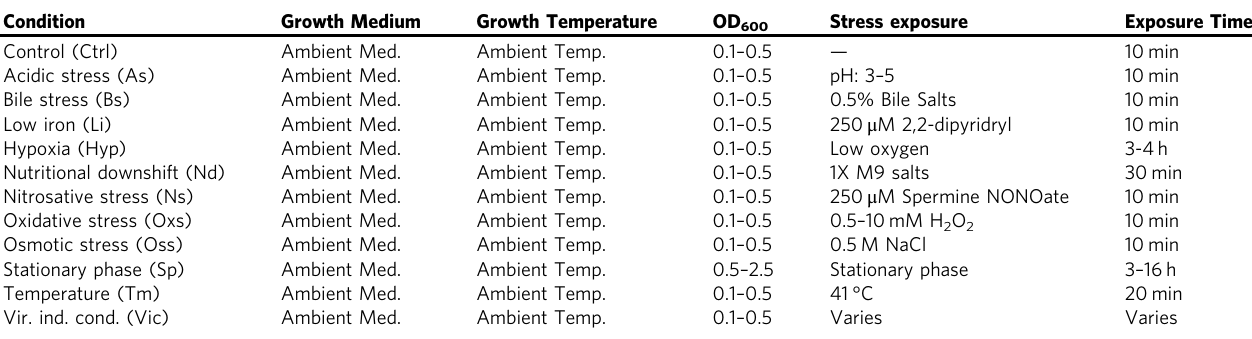
Table 1 The consensus in vivo relevant stress conditions. The stress conditions were kept as similar as possible for the accuracy. Minor changes were done for certain species in certain conditions. Detailed information for the growth and stress conditions are shown in Supplementary Data